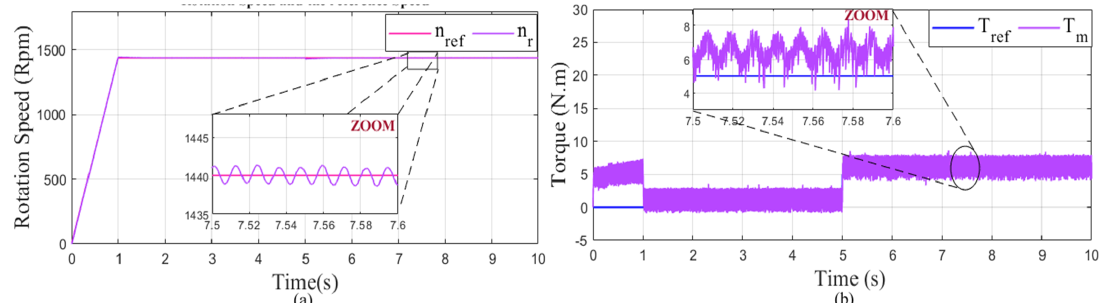
Figure 39. Performance with IR bearing defect of IM with ANN ‐ DTC control: ( a ) rotation speed and ( b ) motor torque.